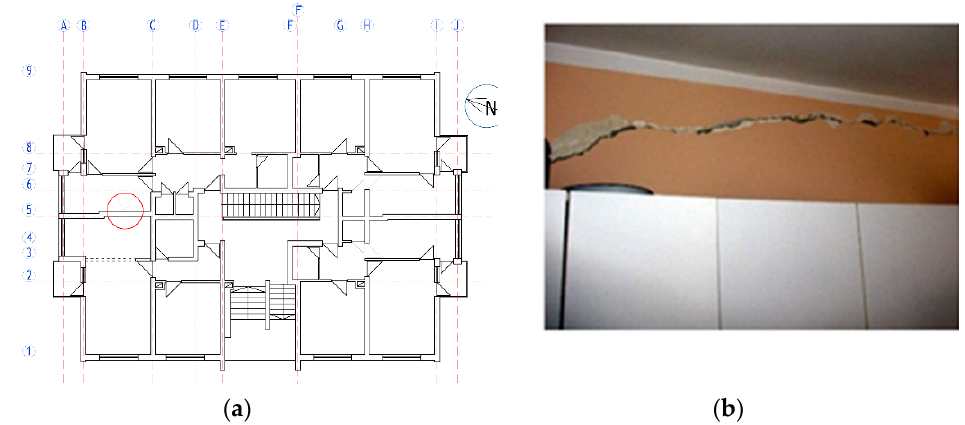
Figure 15. Example of earthquake damage in a case study building: ( a ) floor plan at the second-story level showing a damaged wall (red arrow) and ( b ) severe cracking in a longitudinal wall (gridline 5).